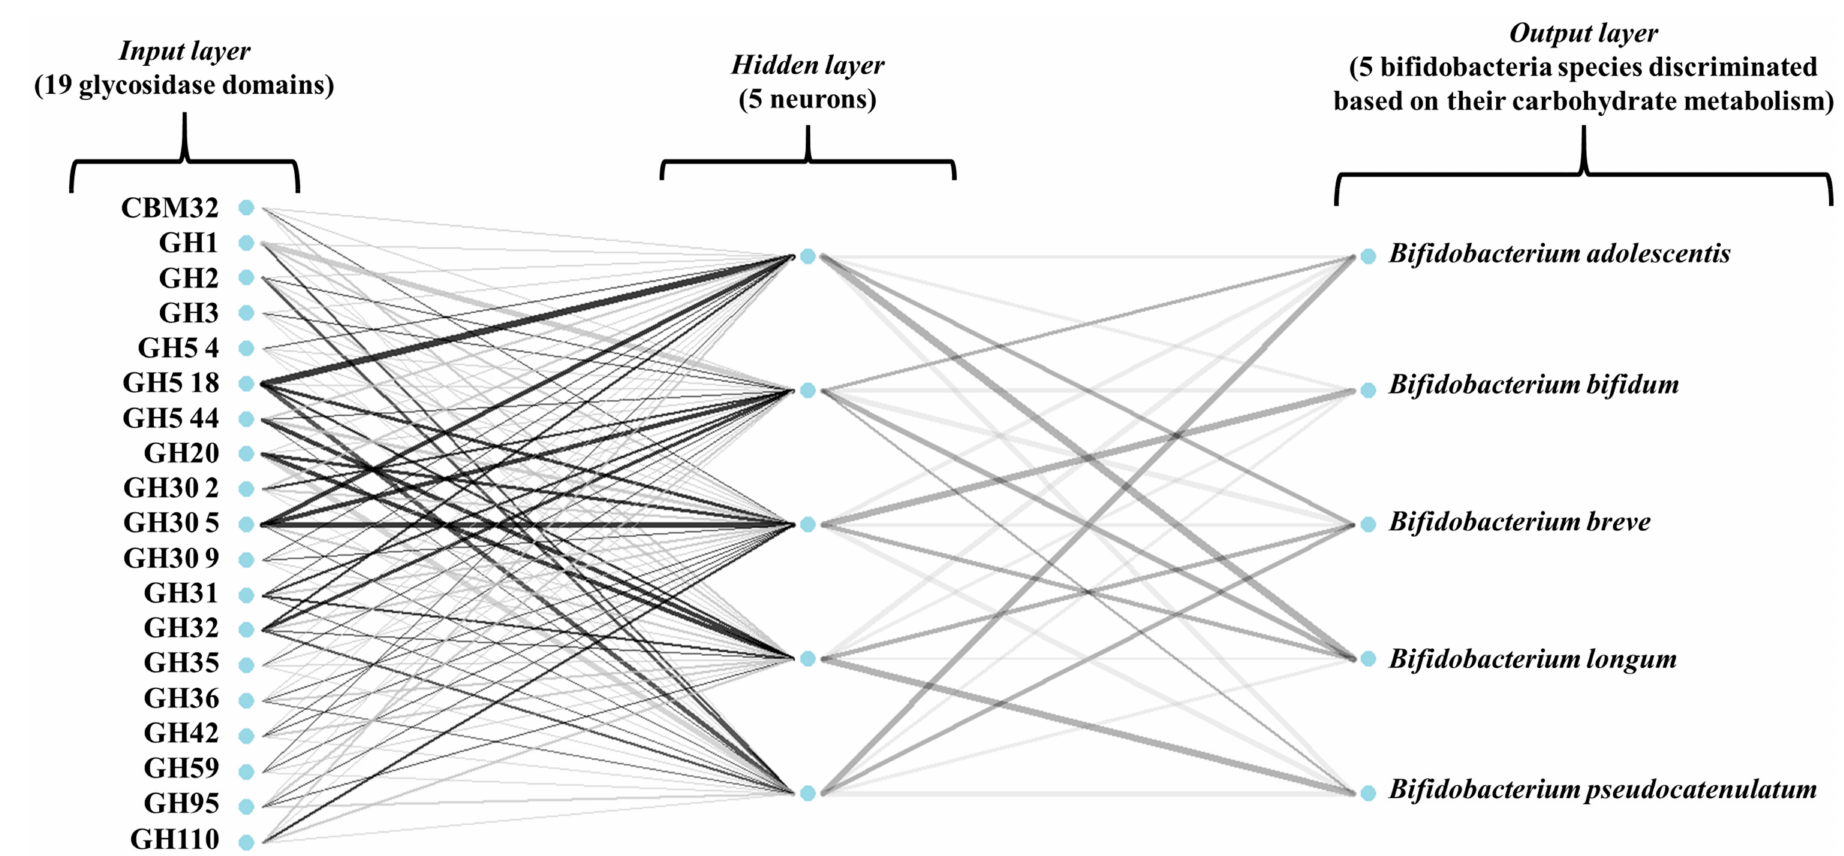
Figure 3. Artificial neural network (ANN) architecture computed to classify metagenome-assembled genomes (MAGs) of B. adolescentis , B. bifidum , B. breve , B. longum and B. pseudocatenulatum based on their glycosidase activities. Weights are color-coded by sign (black +, gray -); thickness is in proportion to